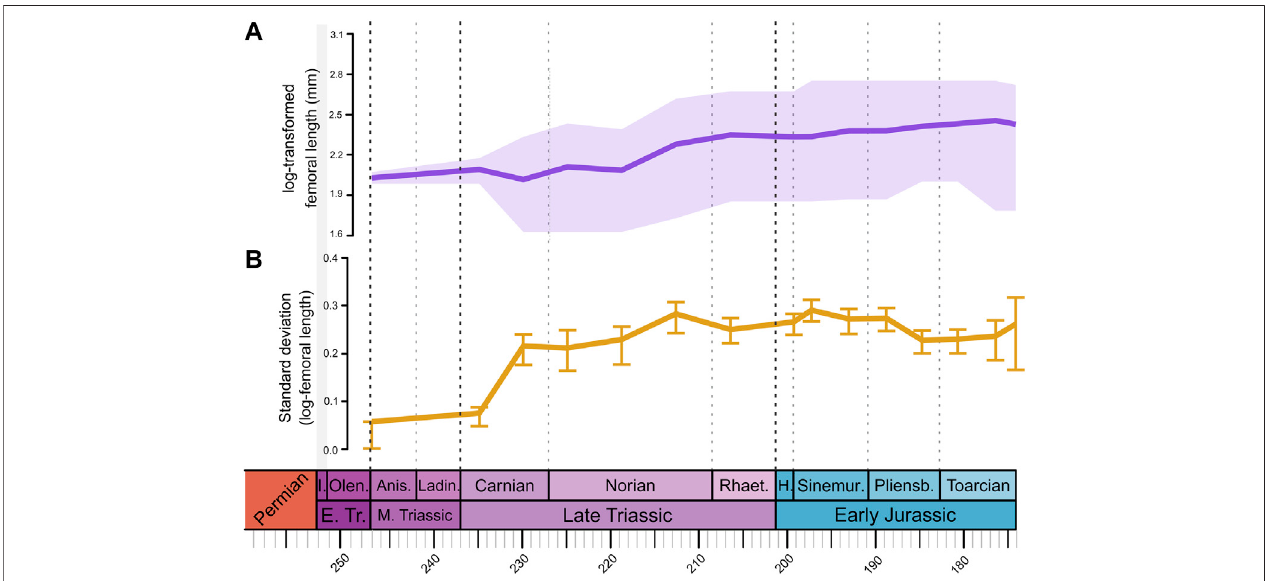
FIGURE 4 | Body size patterns of Triassic to Early Jurassic terrestrial Pan-Aves. (A) Body size represented by log-transformed femoral length in millimeters. Solid purple line represents mean body size, light purple shade indicates maximum and minimum sizes. (B) Solid yellow line represents body size disparity, estimated by calculating the standard deviation for each time bin. Error bars estimated by bootstrapping the data 500 times. Timescale abbreviations: as in Figure 1 .